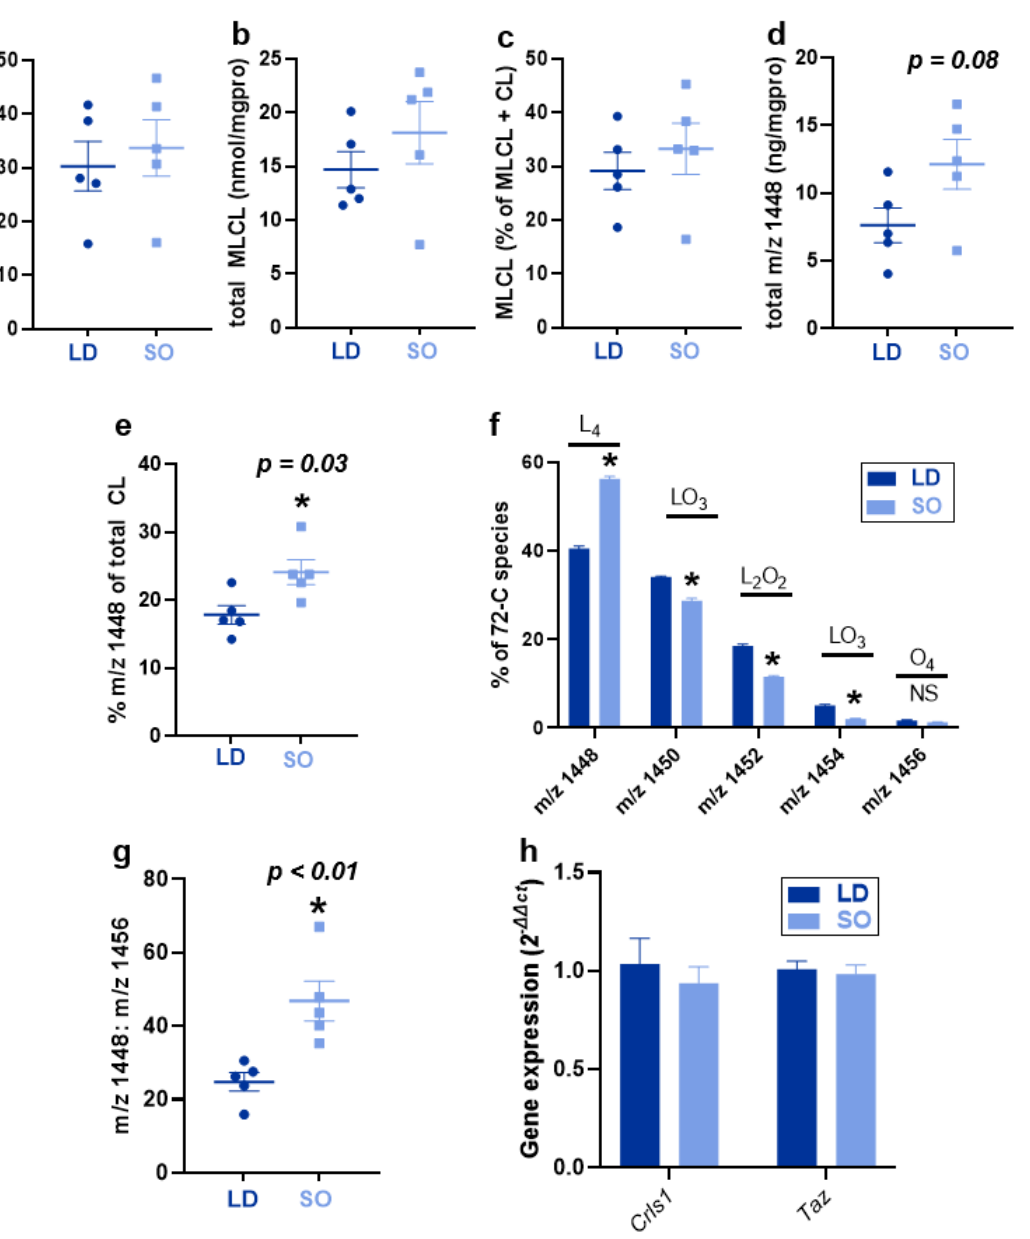
Figure 3. Effect of LD and SO diet consumption on total CL, monolyso-CL, 72-carbon CL species, and gene expression of CL synthesis and remodeling enzymes in BAT. CL was measured using normal phase liquid chromatography coupled with electrospray ionization mass spectrometry and reported relative to quantified protein levels in the sample. ( a ) Total CL. ( b ) Total monolyso-CL (MLCL). ( c ) MLCL as a percent of the total MLCL + CL in each tissue sample. ( d ) Total mass:charge ( m / z ) 1448 (predominant acyl species L 4 CL) and ( e ) Am/z of 1448 as a percent of the total CL in each tissue sample. ( f ) The 72-carbon species of CL in each diet group expressed as a percent of the total 72C species with the major species of CL for each m / z value written above each set of bars. ( g ) Ratio between m / z 1448 and m / z 1456 (predominant acyl species O 4 CL). ( h ) Gene expression of cardiolipin synthase ( Crls1) and tafazzin ( Taz) , expressed as the relative fold change (2 −ΔΔ ct ). For all data, data are expressed as the mean + SEM. A two-sample t -test was used to determine significant differences between diet groups. An asterisk (*) designates p < 0.05, with p -values for < 0.10 reported in the figure. N =